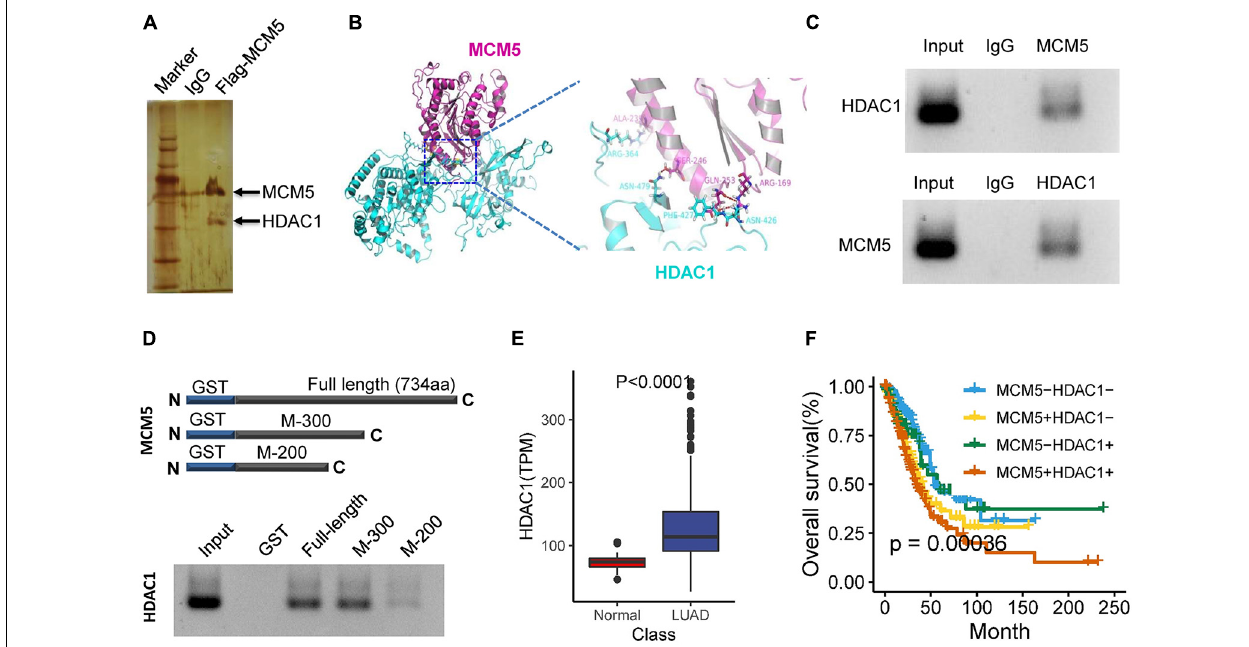
FIGURE 3 | MCM5 interacted with HDAC1 and was correlated with poor survival in lung cancer. (A) Silver staining identifies the interacting proteins of MCM5. (B) Molecular docking between MCM5 (PDBID: 6XTX) and HDAC1 (PDBID: 4BKX). (C) Co-immunoprecipitation was used to detect the interaction between MCM5 and HDAC1 in A549 cells. (D) In vitro interaction analysis of truncated MCM5 and HDAC1. (E) HDAC1 expression level in lung cancer tumors and normal liver tissues based on the TCGA dataset. (F) Survival analysis of TCGA samples for the relationship of survival time with MCM5 and HDAC1 expression levels in patients with lung cancer. Data are presented as mean ± SD. * P <